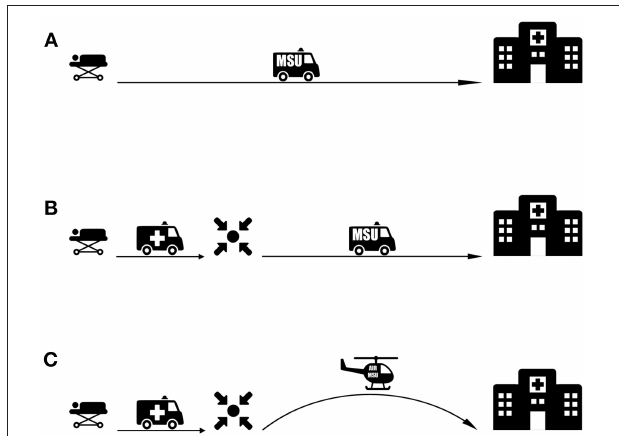
FIGURE 3 | MSU-based transport strategies for patients with LVO. (A) An MSU-based model where imaging and triage is performed onsite and the patient is transported directly to a CSC. (B) Rendezvous approach extending MSU range for rural areas. A conventional ambulance transports the patient to a rendezvous point with the MSU. After MSU-based imaging and diagnosis, the patient is transported directly to a CSC. (C) Proposed Rendezvous approach with an Air-MSU suitable for remote areas with large transit